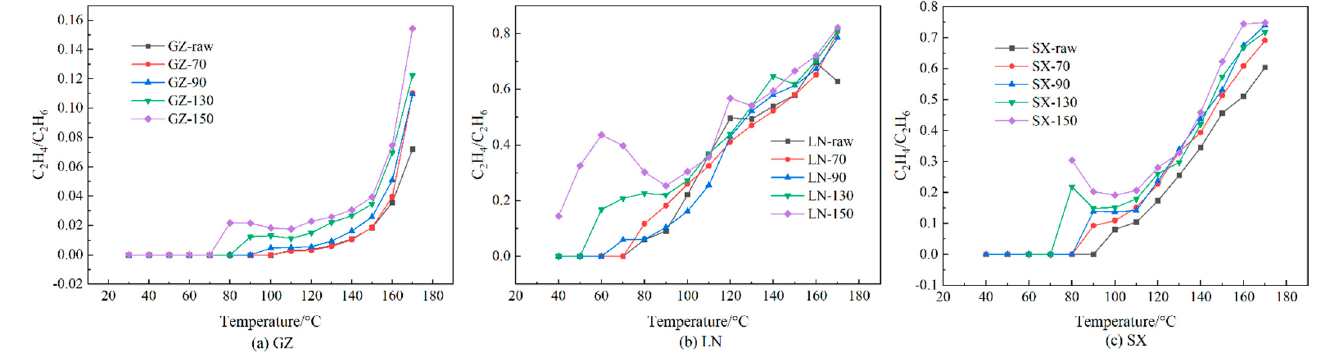
Figure 9. Olefin–alkane ratio during temperature programming: (a) GZ; (b) LN; (c) SX.